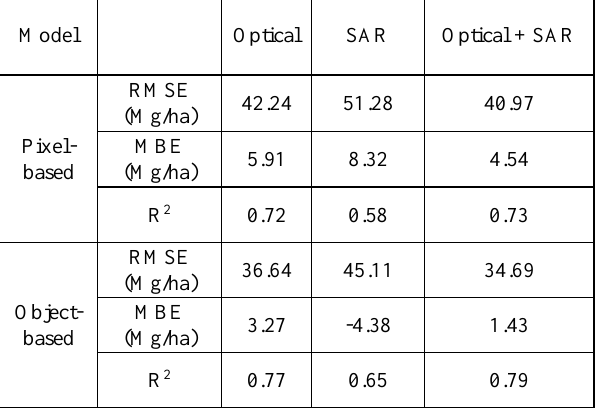
Table 3 . Comparison of pixel-based and object-based PDF forest AGB estimation using Xgboost regression model for optical, SAR, and optical + SAR data.